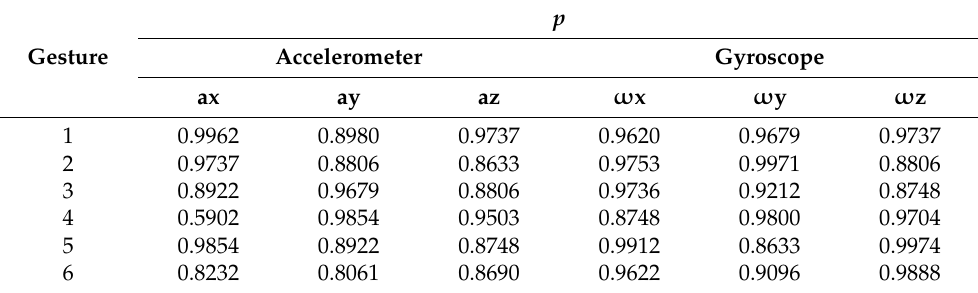
Table 6. Probabilities obtained from testing the significance of differences between the AUCs calcu- lated based on the complete data and after applying the algorithm.